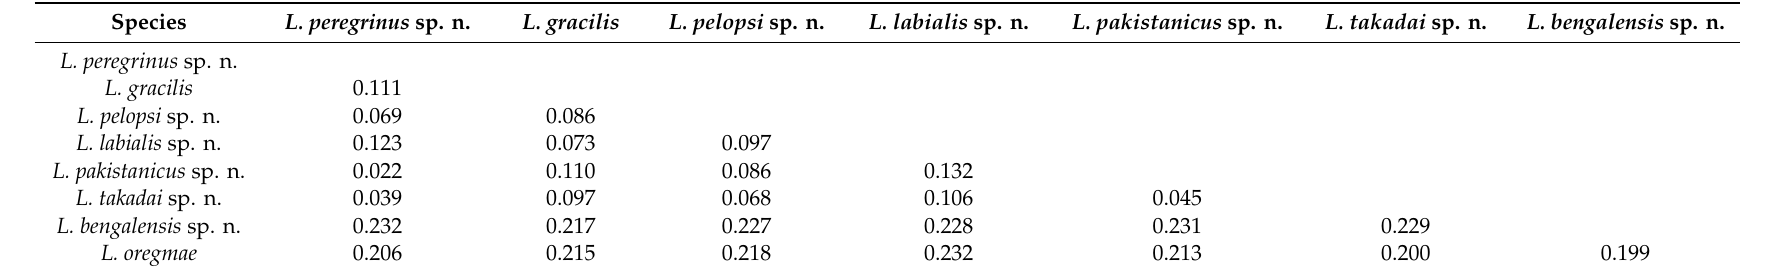
Table 1. Average genetic distances for the COI gene between eight Lipolexis